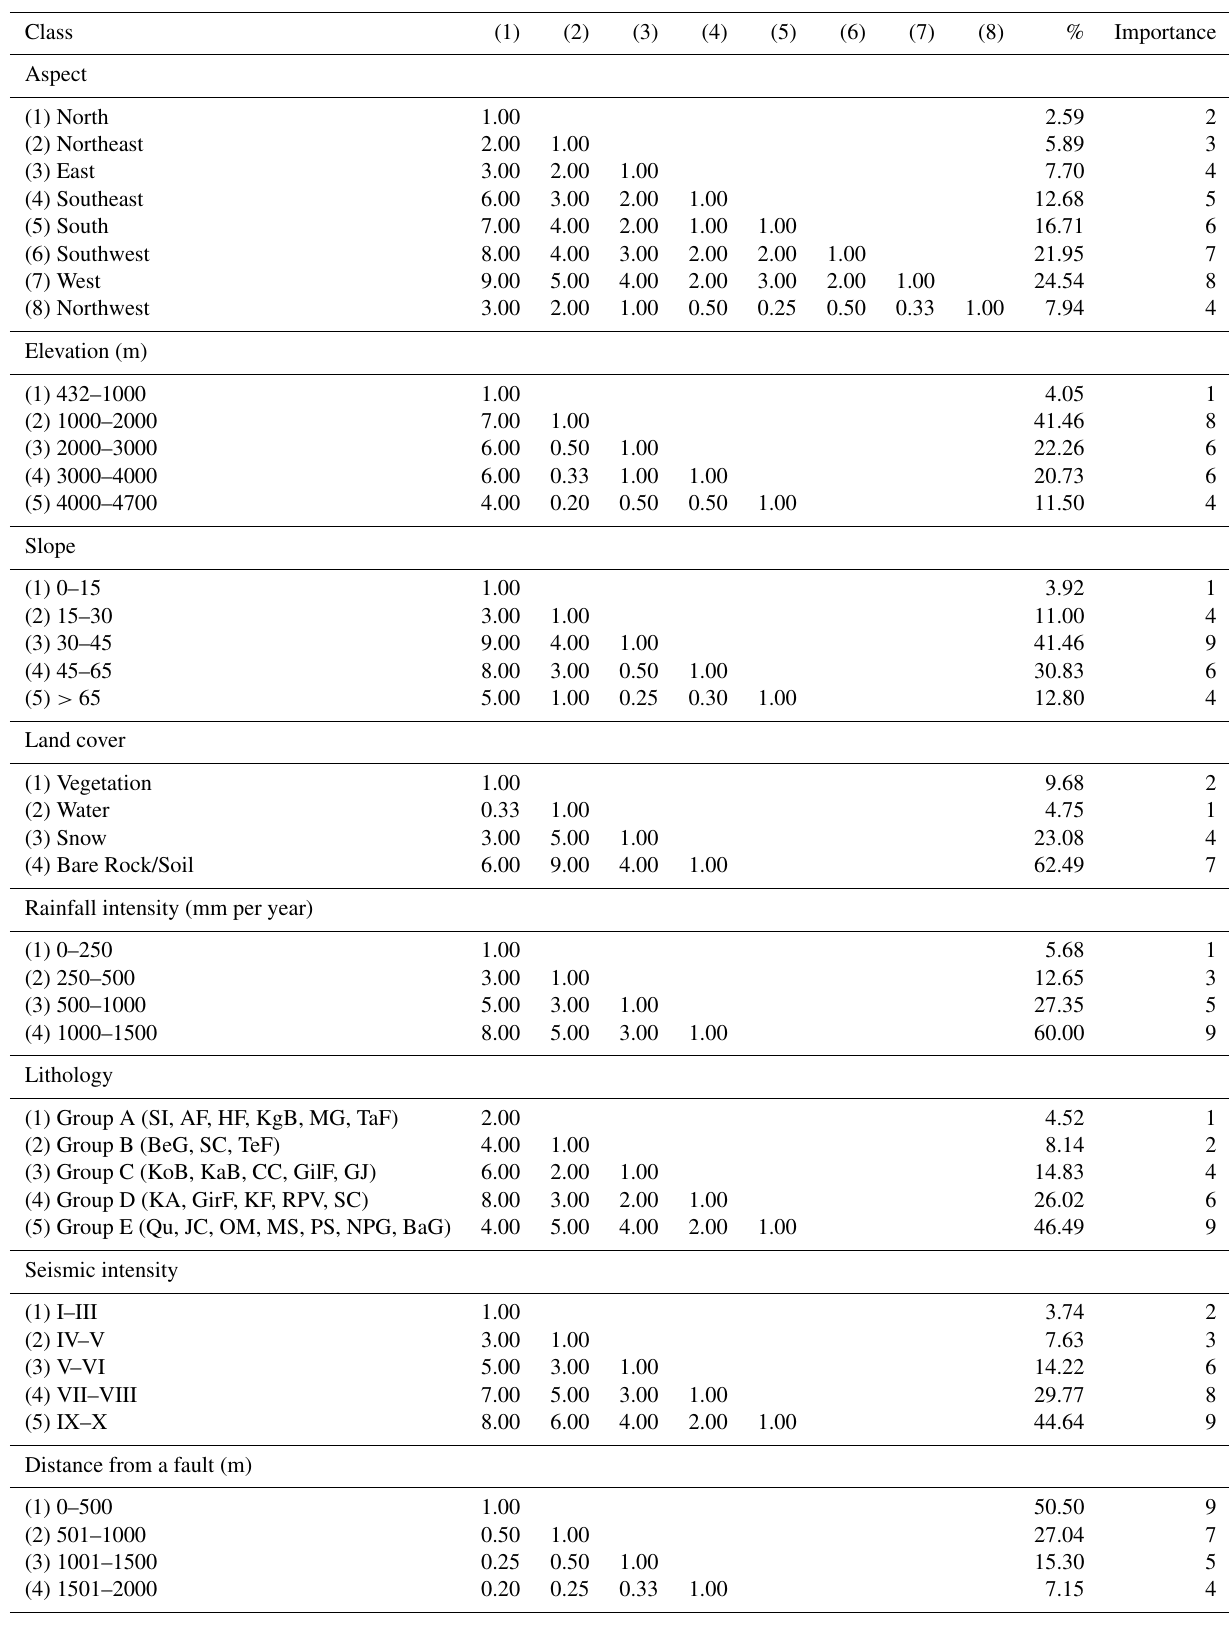
Table 4. Pairwise matrix and weights of factor subclasses.